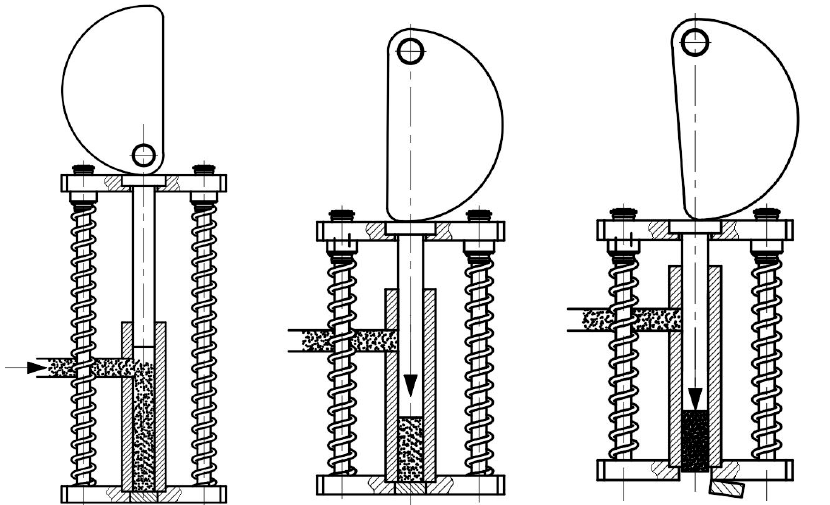
Figure 19. The phases of a single sawdust compaction cycle. We begin with the stage of filling the sleeve, as visible on the left, followed by compaction and, finally, we have the last phase of forcing out the compacted material.